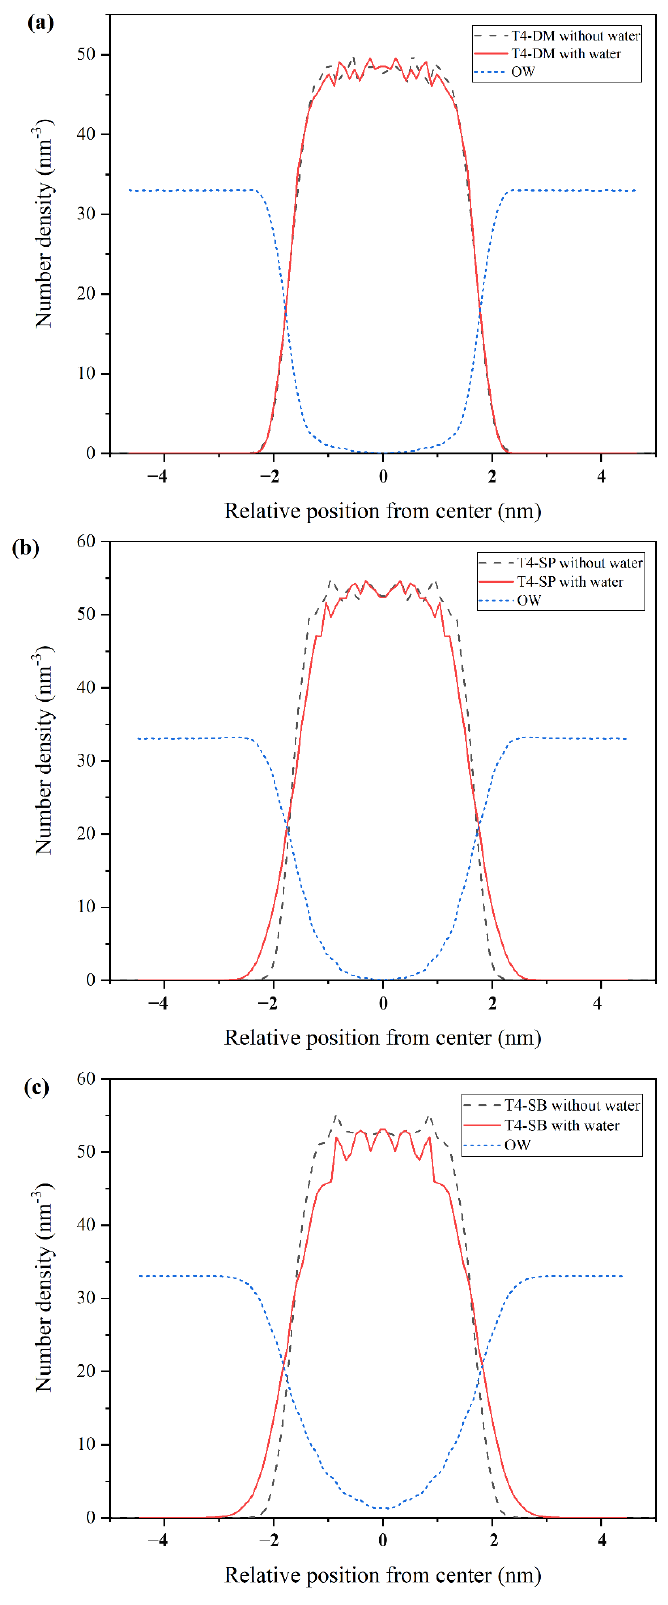
Figure 3. Density profiles along z-axis. ( a ) T4-DM, ( b ) T4-SP, ( c ) T4-SB. Black dashed lines and red lines represent density of antifouling membranes under dry state or hydrated states. Dotted blue lines represent density of water.